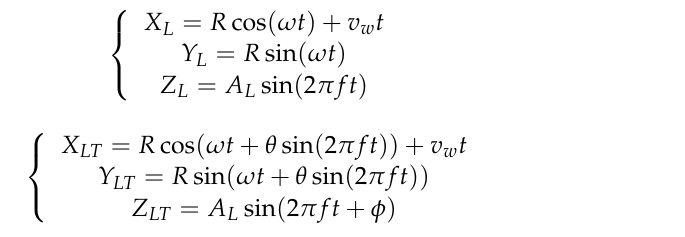
Figure 1. Longitudinal – torsional coupled ultrasonic transducer. ( a ) Transducer of the longitudinal – torsional coupled ultrasonic tool holder. ( b ) Method of the measurement. ( c ) Longitudinal vibration. ( d ) Torsional vibration. ( e ) Amplitude- frequency curve.